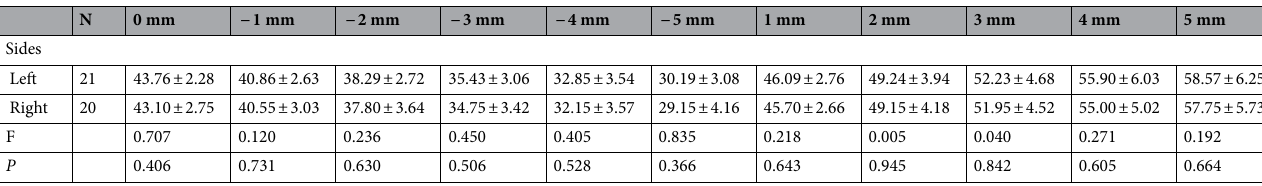
Table 3. The comparison of cup’s inclination in different sides of normal developmental hips (x ± s).